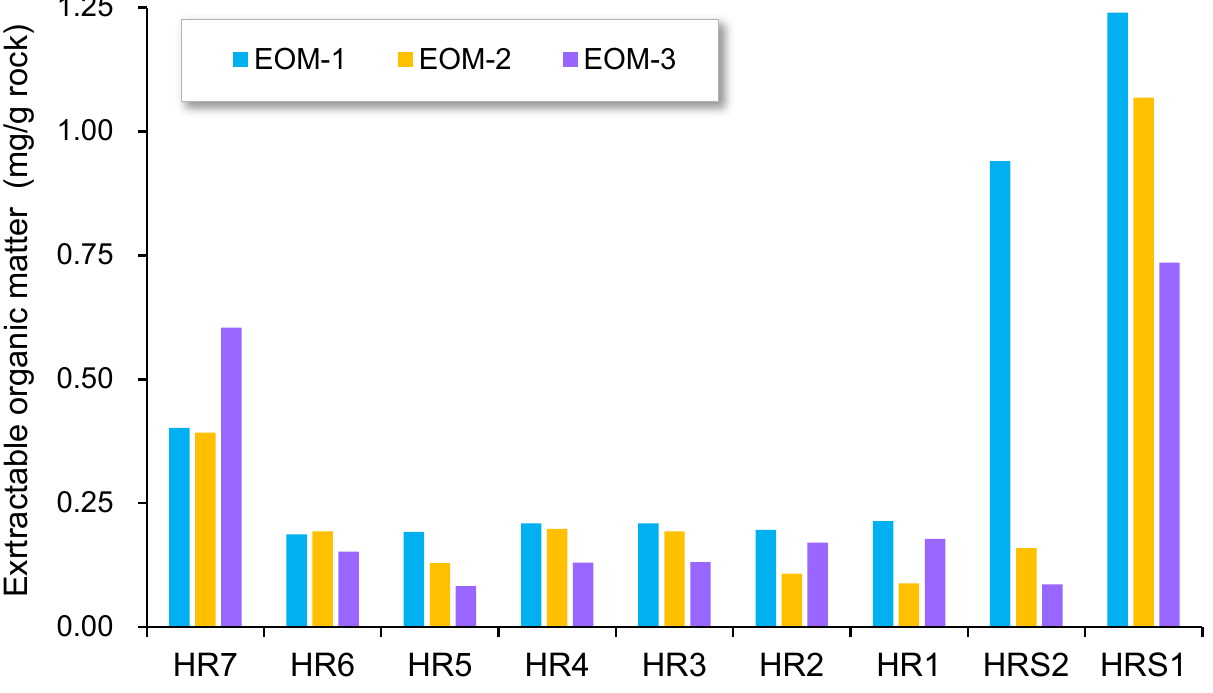
Figure 4. The amounts of extractable organic matter from sequential extraction.